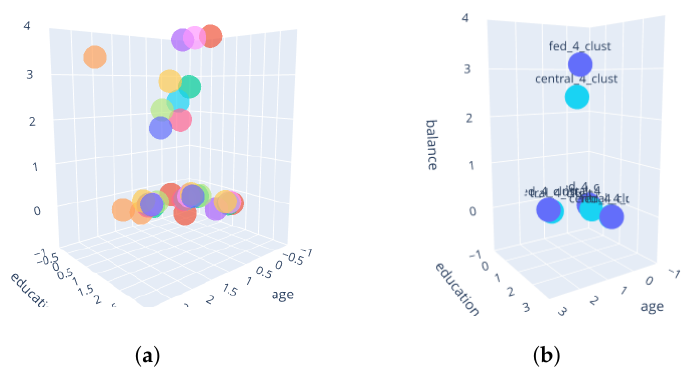
Figure 7. ( a ) Local-only clustering results for K = 4 of the clients in one plot. Each color corresponds to one client. ( b ) Federated and centralized cluster centers for K = 4. The darker points are the federated cluster centers and the brighter points are the central cluster